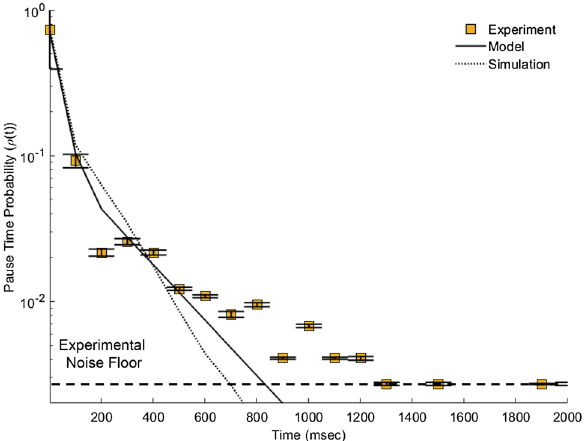
Figure 6. Anterograde-driven transport pause distribution as a function of time. The SVP traverse fraction (t = 0 ms) is included along with the model fit at that data point for context. Experimental data shows a decrease in pause-time probability with increasing time (Yellow squares, N = 737). Both the analytical model (Eq. 1, solid line, Pd = 0.5) and the coarse-grained computational simulation (dashed line, Pd = 0.65) reproduce the observed experimental results. The lower-limit of pause-time fraction used to fit to the model was the gaussian random noise (1/Number of SVPs, “Experimental Noise Floor”, dashed